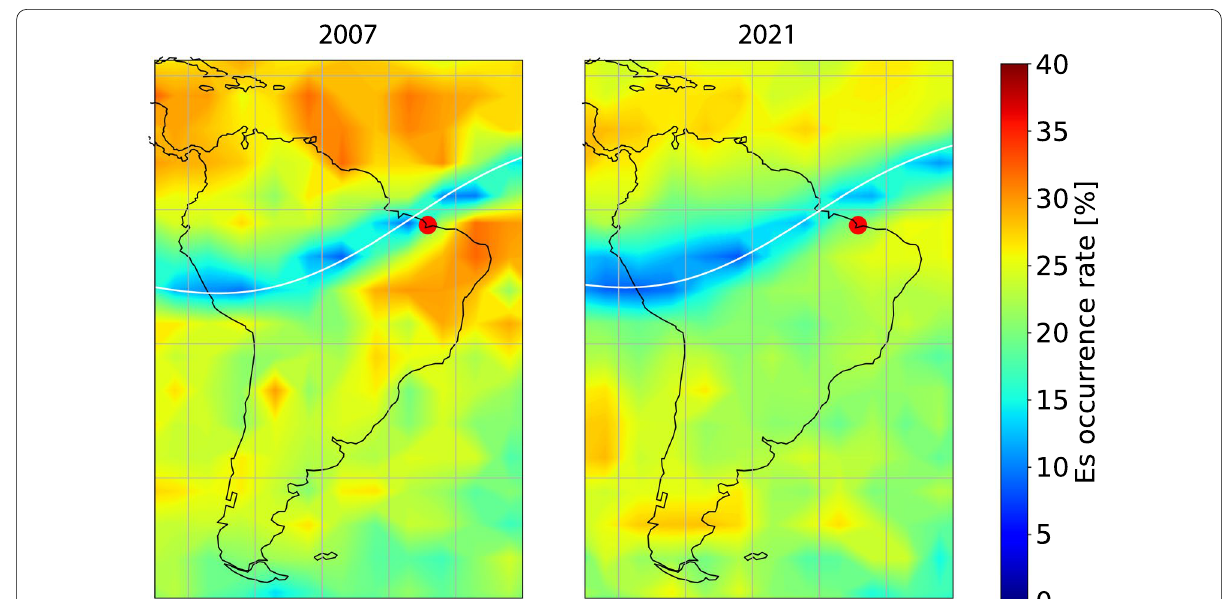
Fig. 9 Sporadic E occurrence rates in the South American region in 2007 (left) and 2021 (right). The São Luís ionosonde station is marked with a red circle. The position of the magnetic equator is given as a white